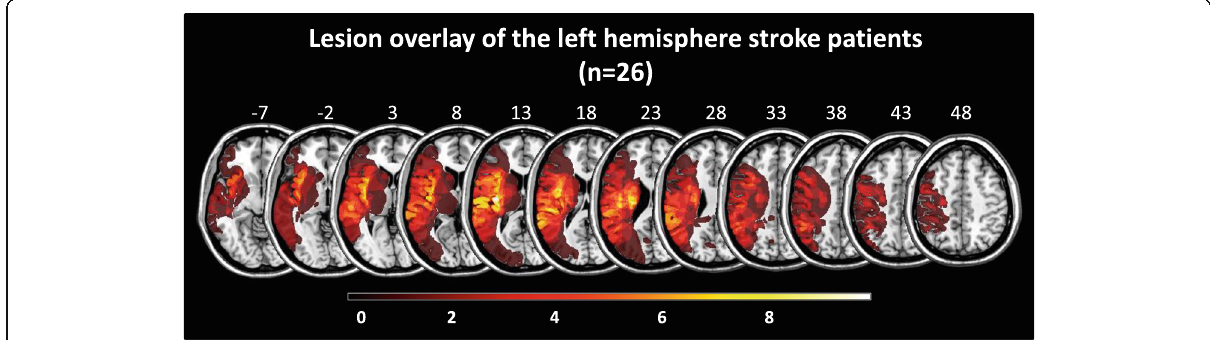
Fig. 1 Lesion distribution in the current sample of left hemisphere (LH) stroke patients ( n = 26). Note that for four patients no scan suitable for lesion mapping was available. Color shades represent the increasing number of overlapping lesions. Slices with the MNI-z-coordinates from − 7 to 48 are